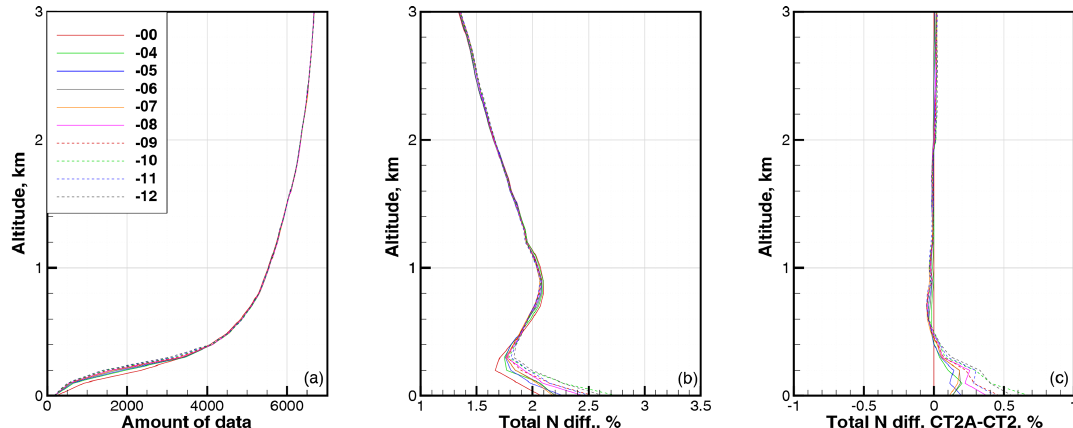
Figure 7. Statistics for latitude band 40–50 ◦ . (a) Amount of data. (b) RMS relative difference in refractivity COSMIC–ECMWF (cid:49)N CE . (c) RMS relative difference in refractivity CT2A–CT2. All are functions of the parameter β